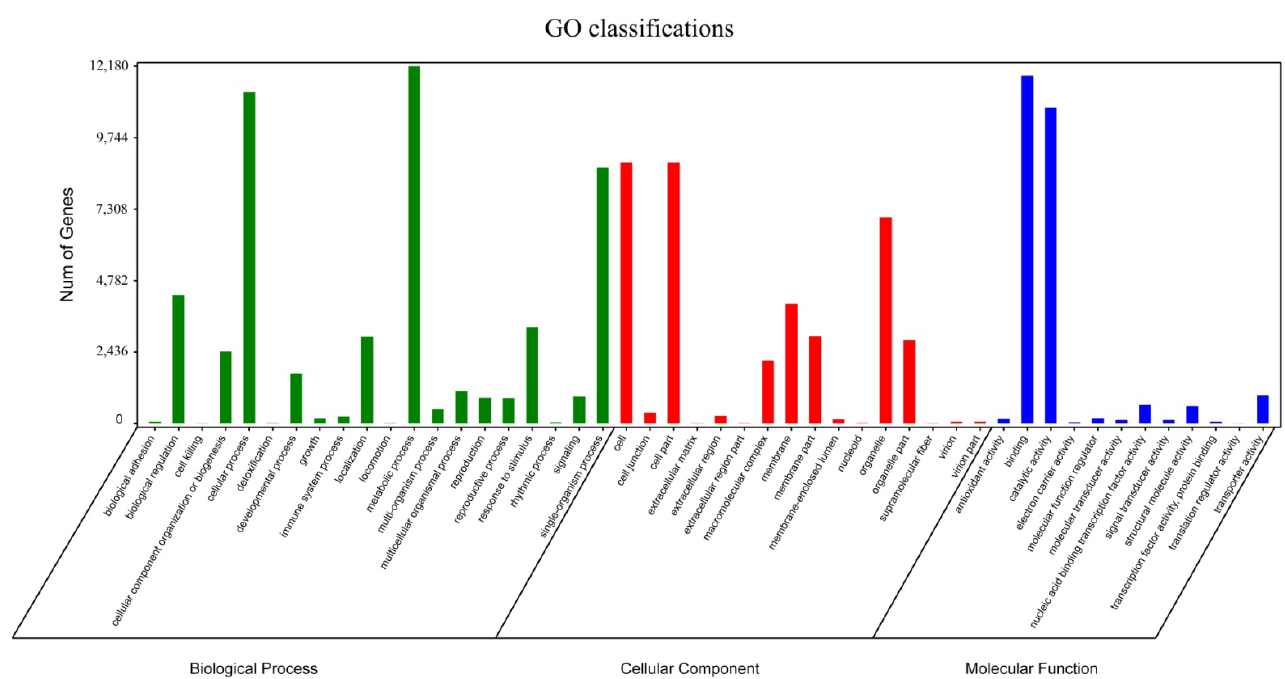
Figure 3. Gene ontology (GO) term level 2 categories of unigenes of the ‘Huaxiu’ plums ( P. salicina ).